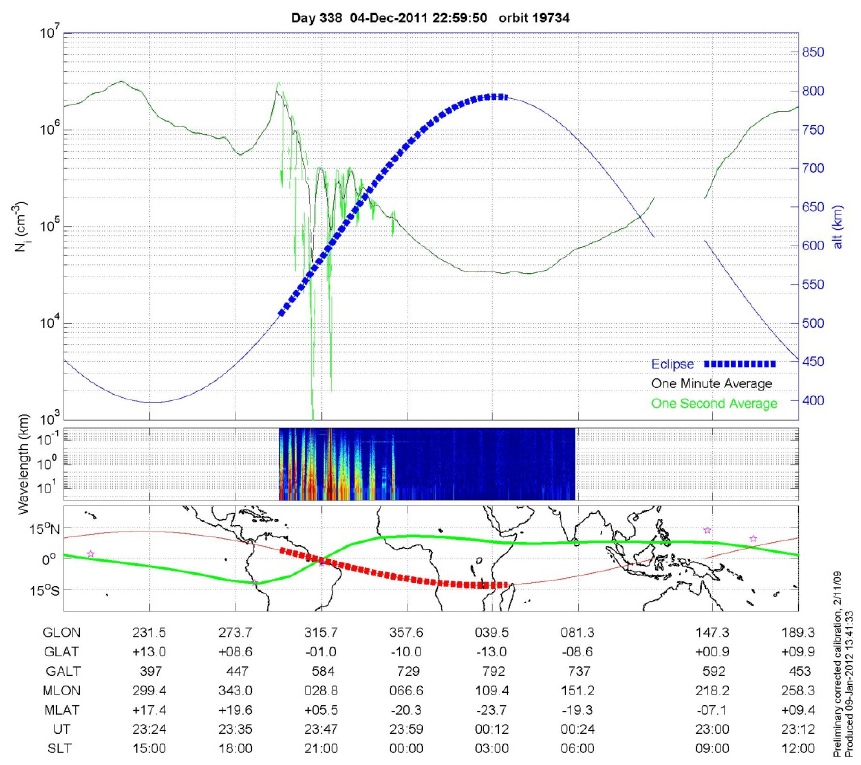
Figure 1. Orbit 19734, 04 December 2011. (top) One-minute average ionospheric density (black line); one-second average density (green line); and satellite altitude (blue line). (middle) FFT from the 512 Hz PLP data. (bottom) Map with satellite trajectory (red) and magnetic equator (green). Thick dotted lines indicate when the C/NOFS satellite is in darkness.